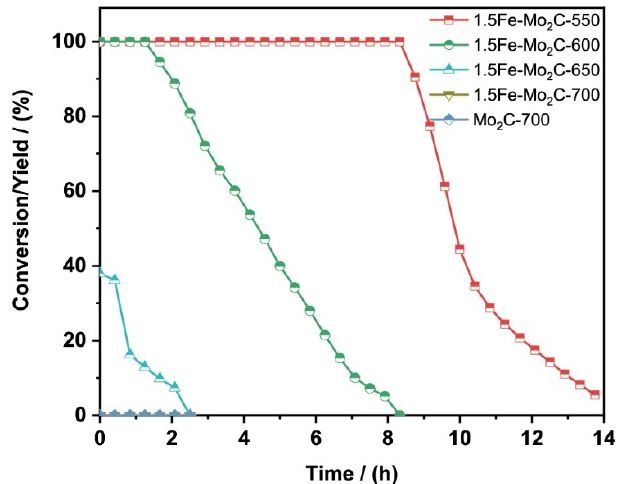
Figure 6. Effect of carburization temperature (1.5Fe-Mo 2 C-T, T = 550, 600, 650, 700 °C) on toluene hydrogenation. (3.0 MPa of total pressure, 100 ° C as reaction temperature, 0.15 h − 1 as WHSV, employing newly synthesized Fe-doped molybdenum carbide catalysts).